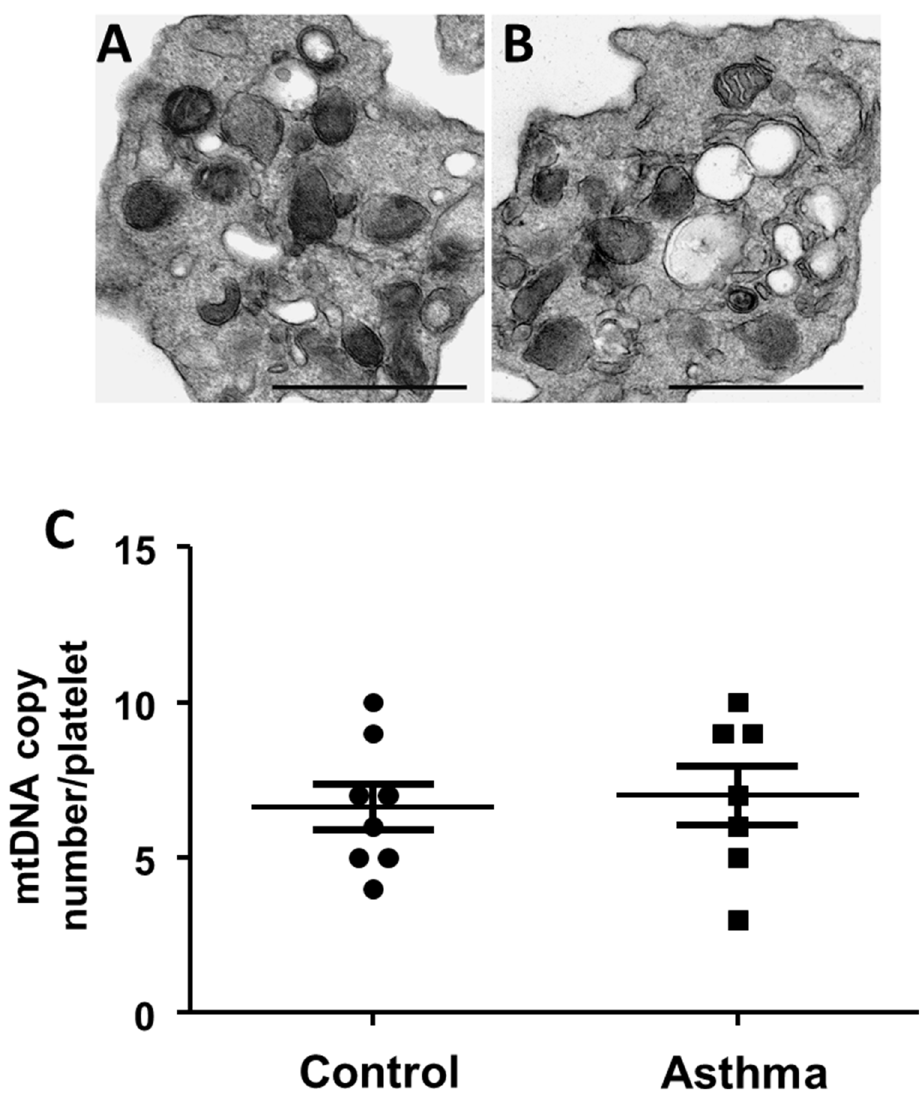
Mitochondrial DNA copy number per platelet in platelets from healthy and asthmatic individuals. n = 7 per